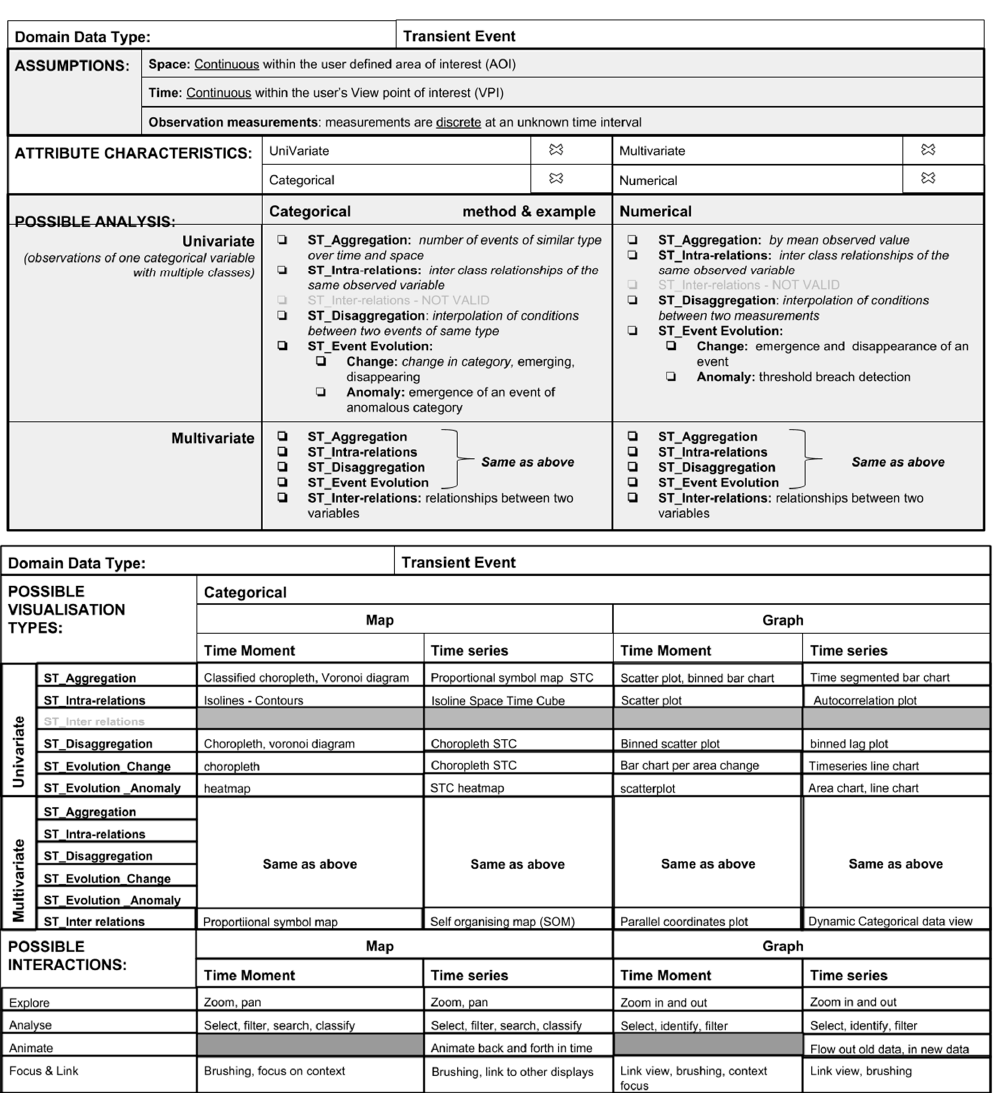
Figure A1. Framework preparation for visual analytics of transient events